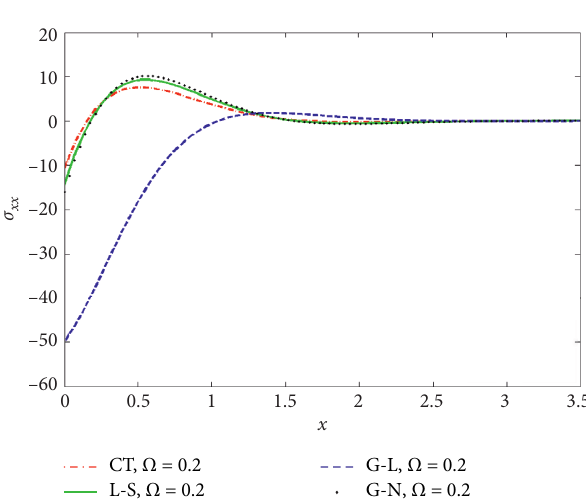
Figure 4: Stress σ